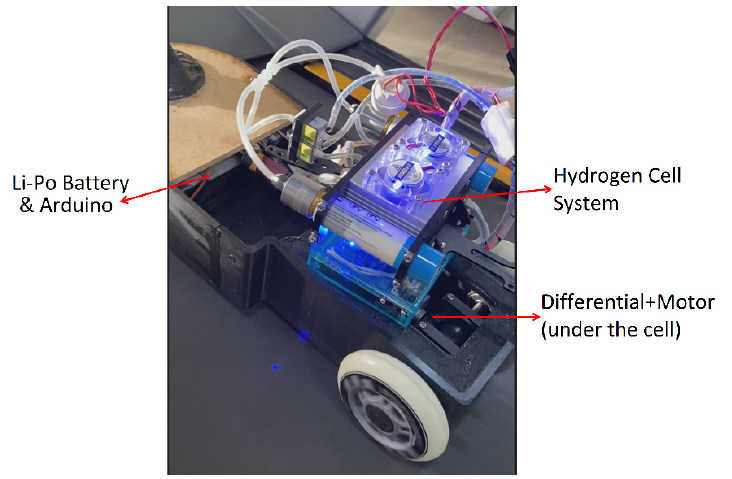
Figure 5. Back view of the vehicle showing the hydrogen cell assembled.